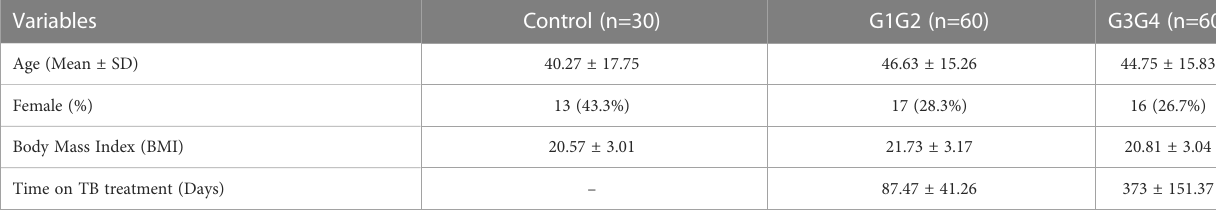
TABLE 1 Demographic characteristics of the participants (n =